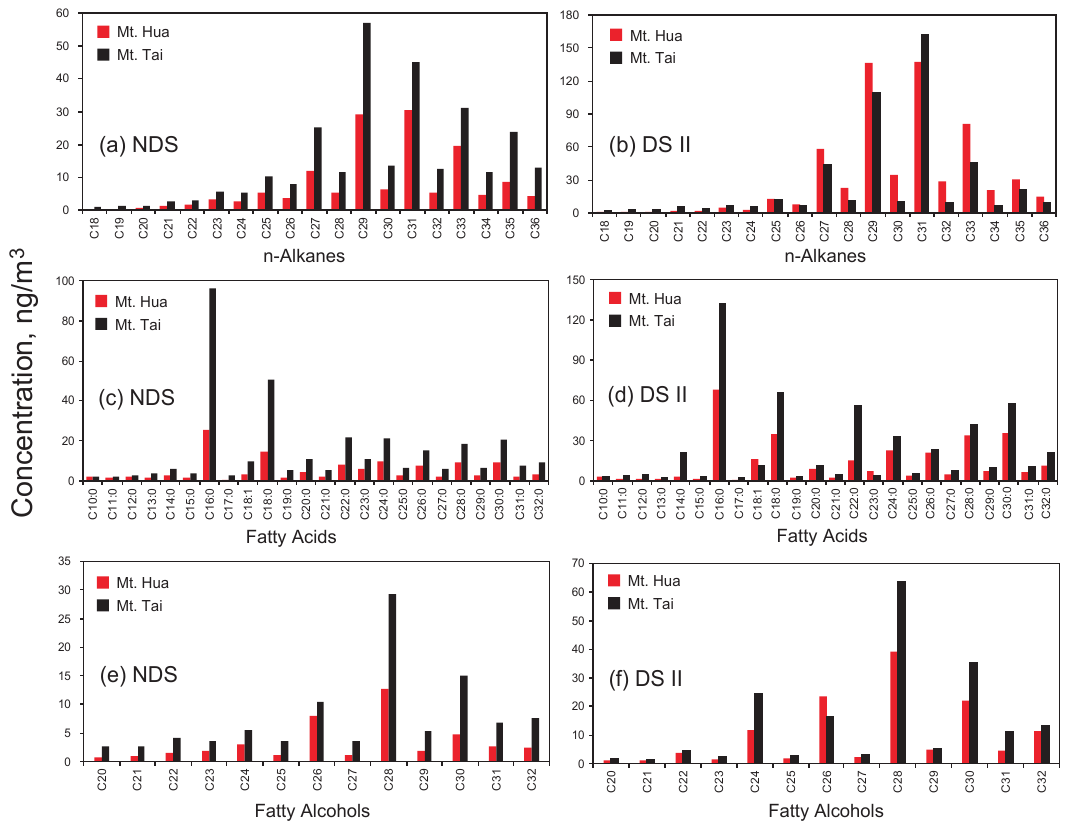
Fig. 4. Differences in molecular composition of n -alkanes, fatty acids and fatty alcohols in the PM 10 samples at Mt. Hua and Mt. Tai during the non-dust storm (NDS) and the dust storm II (DS II, 24 April 2009) periods.